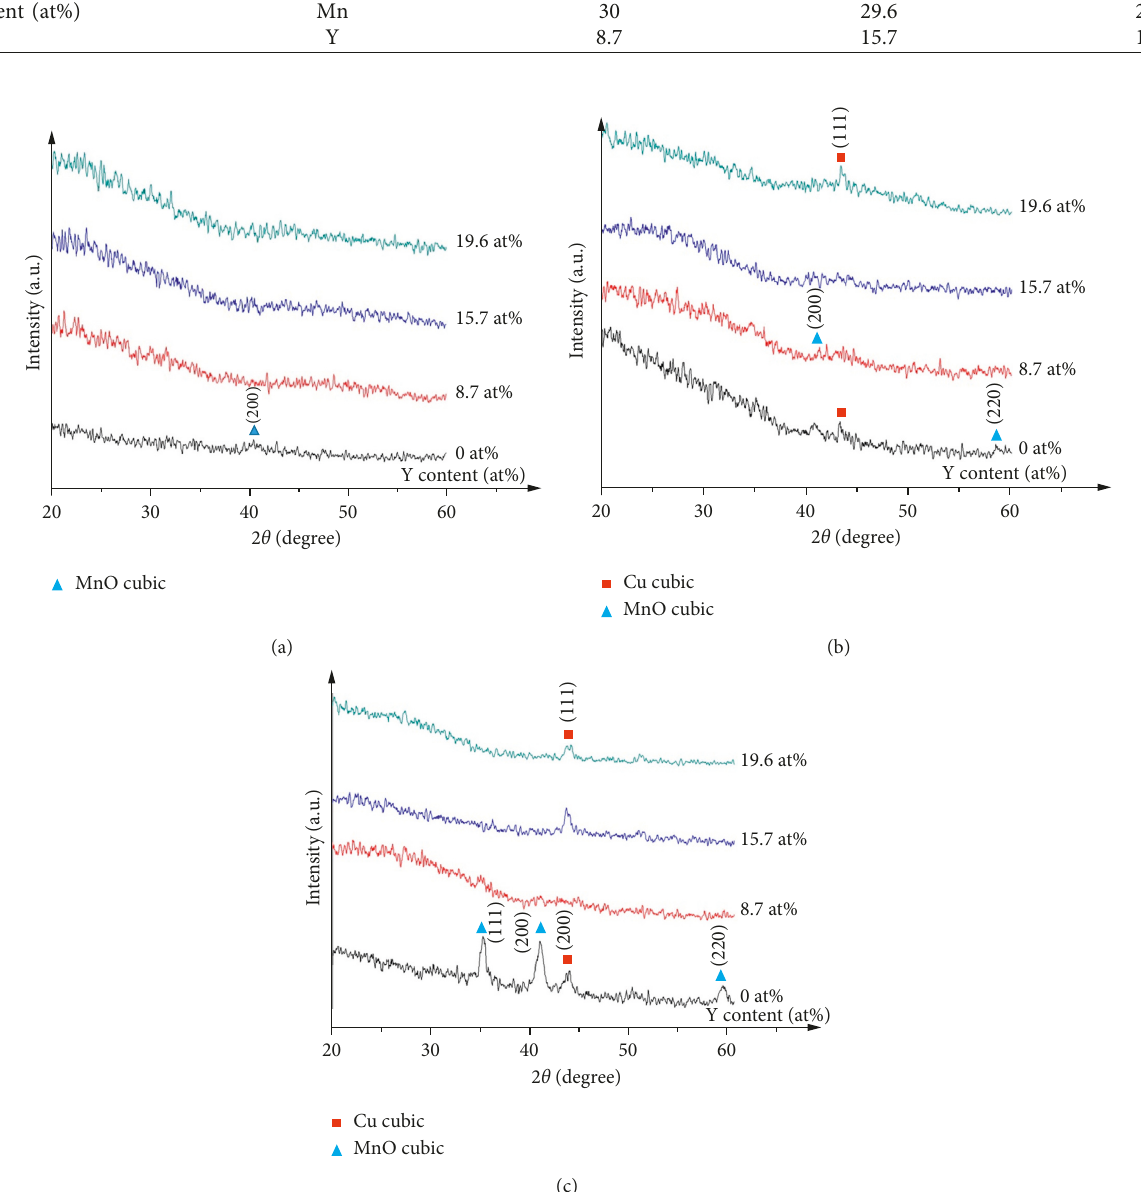
Table 1: CuMnY thin-film composition prepared at DC 50 W with different RF powers sputtered onto cooper sheet. Power (W) DC/RF 50/60 50/80 Cu Element (at%)